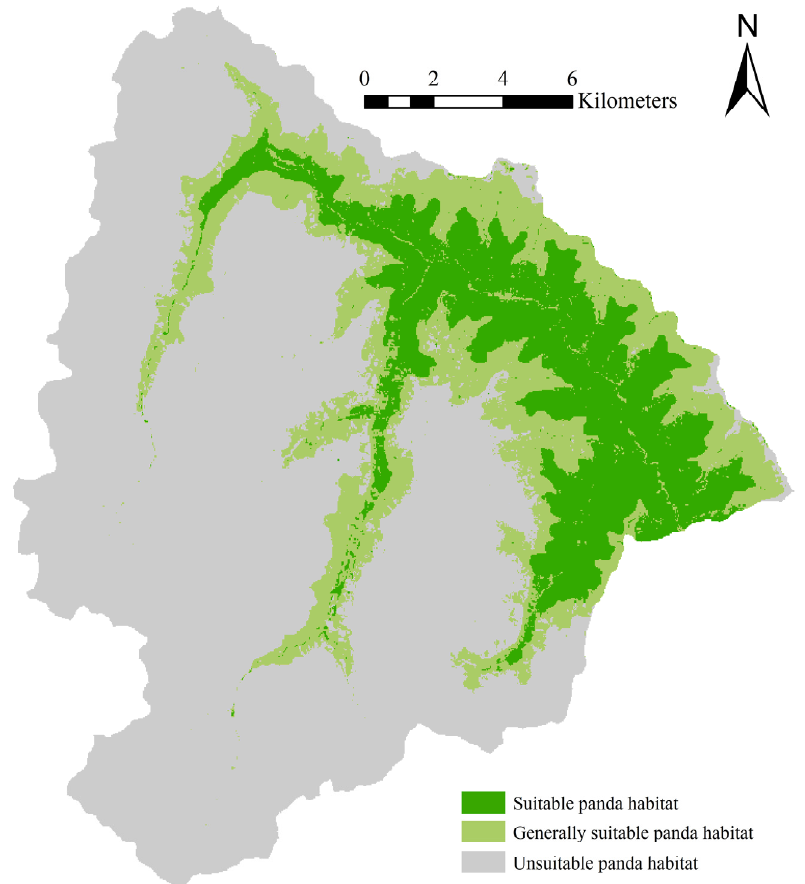
Figure 3. Giant panda habitat across varying suitable grades in Wanglang Nature Reserve.